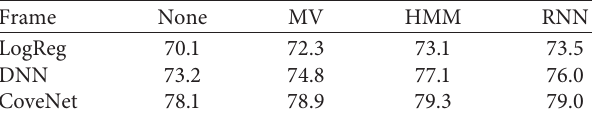
Table 1: Weighted Chord Symbol Recall for the evaluated temporal versions of the 24 major and minor chords and the “no-chord”